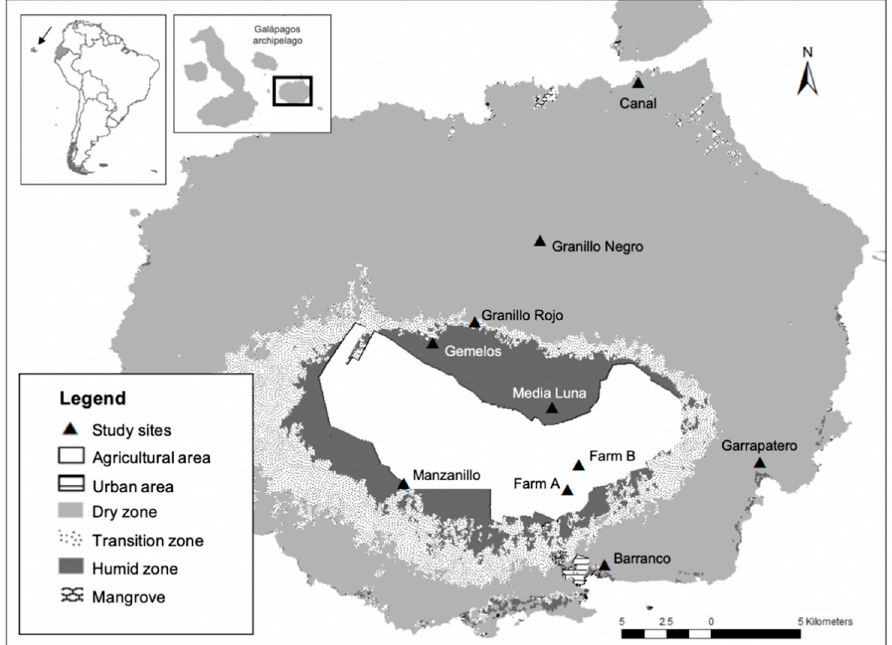
Figure 1. Location of study sites in Santa Cruz Island, Galápagos, Ecuador. Dry zone (4 sites): Barranco, Garrapatero, Granillo Negro and Canal; Transition zone (2 sites): Granillo Rojo and Manzanillo; Humid zone (2 sites): Gemelos and Media Luna; and Agricultural lands (2 sites): Farm A and Farm B (map modified from shapefiles kindly provided by Rivas-Torres et al. [31]). At each site, birds were captured using an array of six mistnets (6 m and 12 m) operated for two days (0600 h-1130 h). Nets were checked continuously. Birds were removed from mist nets and placed in individual cloth bags in a shaded area until processed. Birds were weighed (nearest 0.1 g) using a digital or string Pesola scale and morphometric measurements (head-bill length, exposed culmen, tarsus) were taken with a Vernier dial caliper with a precision of 0.02 mm. A measurement of the unflattened, right wing-chord was taken with a wing ruler (1 mm). Individuals were banded with a uniquely coded aluminum band before release. From each individual, we sampled 2–3 secondary wing coverts; all feathers from one individual were stored in a single paper coin envelope. Envelopes were stored in a plastic box containing silica gel, and kept at room temperature. Feathers were sampled from 231 live birds, belonging to eight species (Table 1 and Supplementary Figure S1): Small Ground Finch (SGF, Geospiza fuliginosa ); Medium Ground Finch (MGF, Geospiza fortis ); Large Ground Finch (LGF, Geospiza magnirostris ); Common Cactus Finch (CF, Geospiza scandens ); Small Tree Finch (STF, Camarhynchus parvulus ); Woodpecker Finch (WF, Camarhynchus pallidus ); Green Warbler Finch (GWF, Certhidea olivacea ); Vegetarian Finch (VF, Platyspiza crassirostris ). We assigned all species to three foraging guilds (following [6,41]). Guilds were: (1) granivorous ground finches (i.e., opportunist feeders primarily on seeds) which included two species, SGF and MGF; (2) herbivorous finches (i.e., feeders on large seeds, leaves, fruits, and nectar), which included LGF, CF and VF; and (3) insectivorous finches (i.e., feeding primarily on small invertebrates), which included STF, GWF and WF (Table 1, Tables S1 and